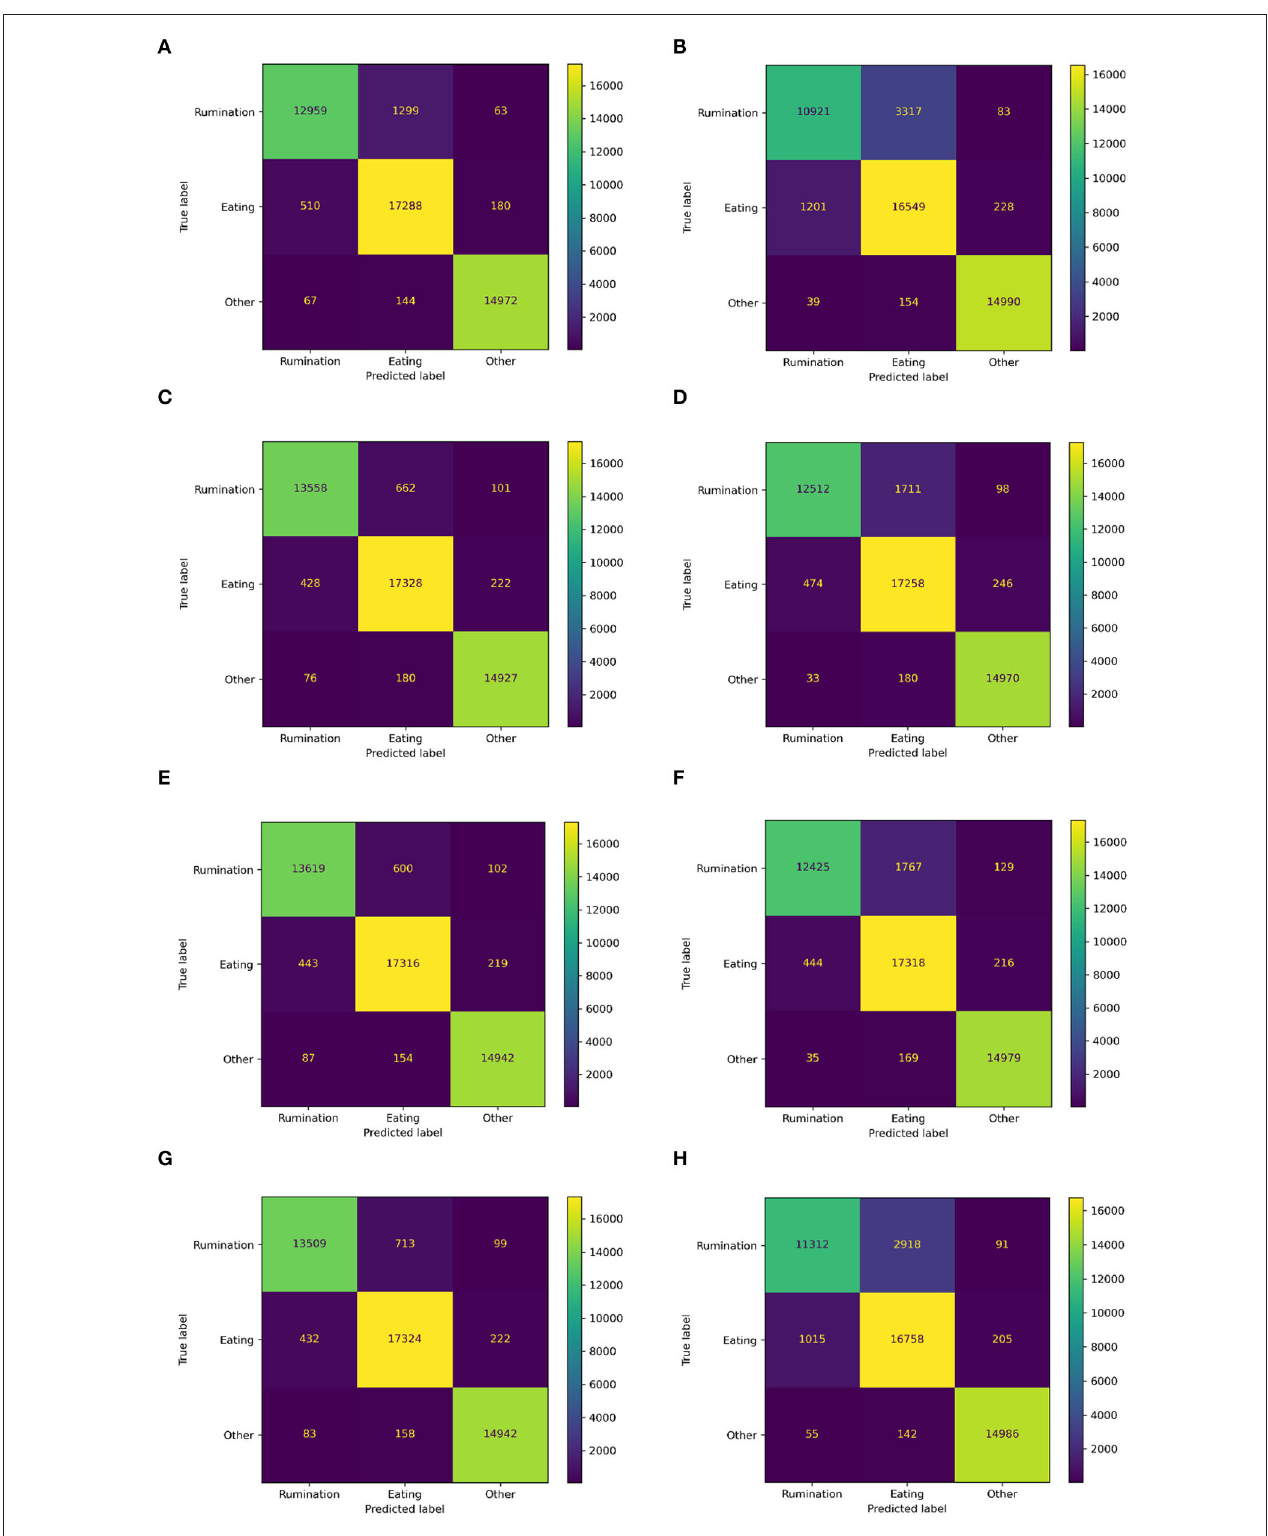
FIGURE 6 | The confusion matrix of each model. FOD, First-order difference; LS, local slope; HPF, high-pass filter; FDF, frequency-domain features; and TDSF, time-domain statistical features. (A) FDF, (B) TDSF, (C) FOD + FDF, (D) FOD + TDSF, (E) LS + FDF, (F) LS + TDSF, (G) HPF + FDF, and (H) HPF + TDSF.